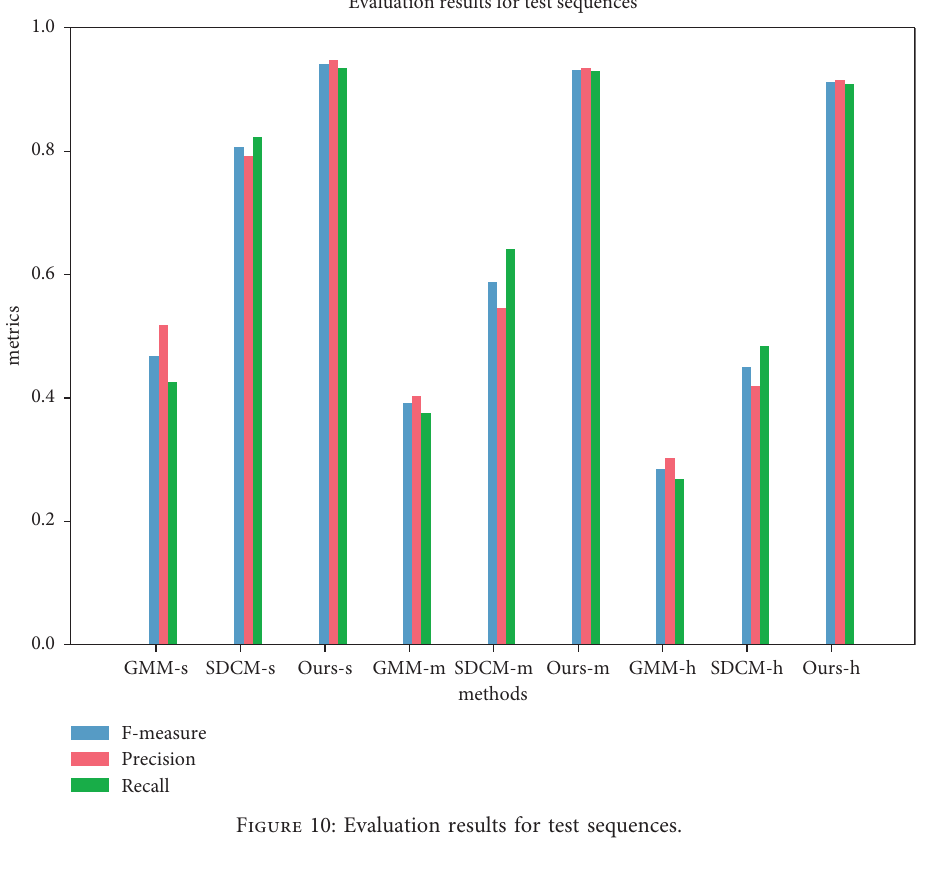
Figure 10: Evaluation results for test